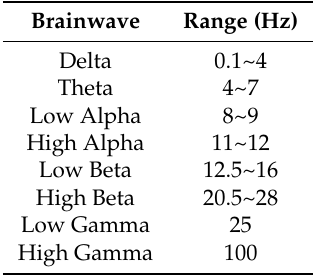
Table 3. Frequency range of EEG